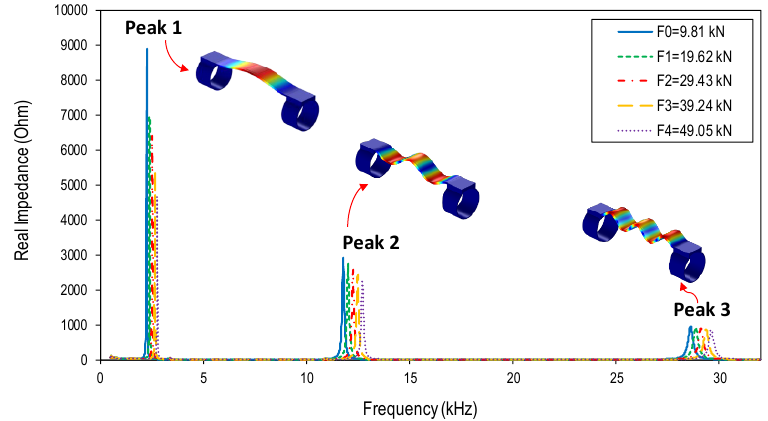
Figure 8. Numerical impedance signatures of wearable PZT interface under different tension forces.